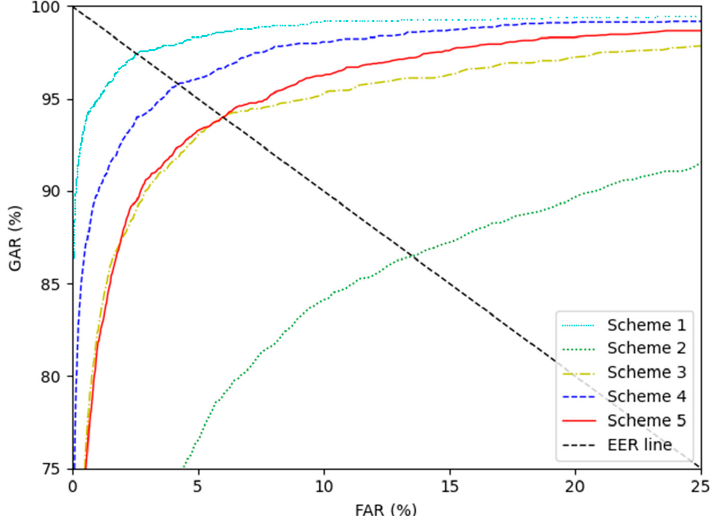
Figure 16. ROC curves of finger-vein recognition for schemes 1–5 with SDU-DB (random motion blur and optical blur with intensity 15 × 15 (Gaussian filter size) and 15 (Gaussian filter standard deviation)).